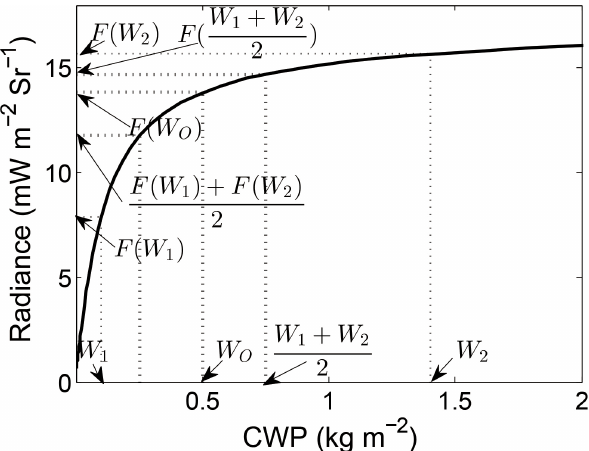
Figure 5. Illustration of the non-linear effects of the observation operator on the calculation of radiance increments with two ensem- ble members. F denotes the observation operator, W 1 and W 2 de- note the cloud water path (CWP) for the first and second ensemble member, respectively, and W O denotes the observed